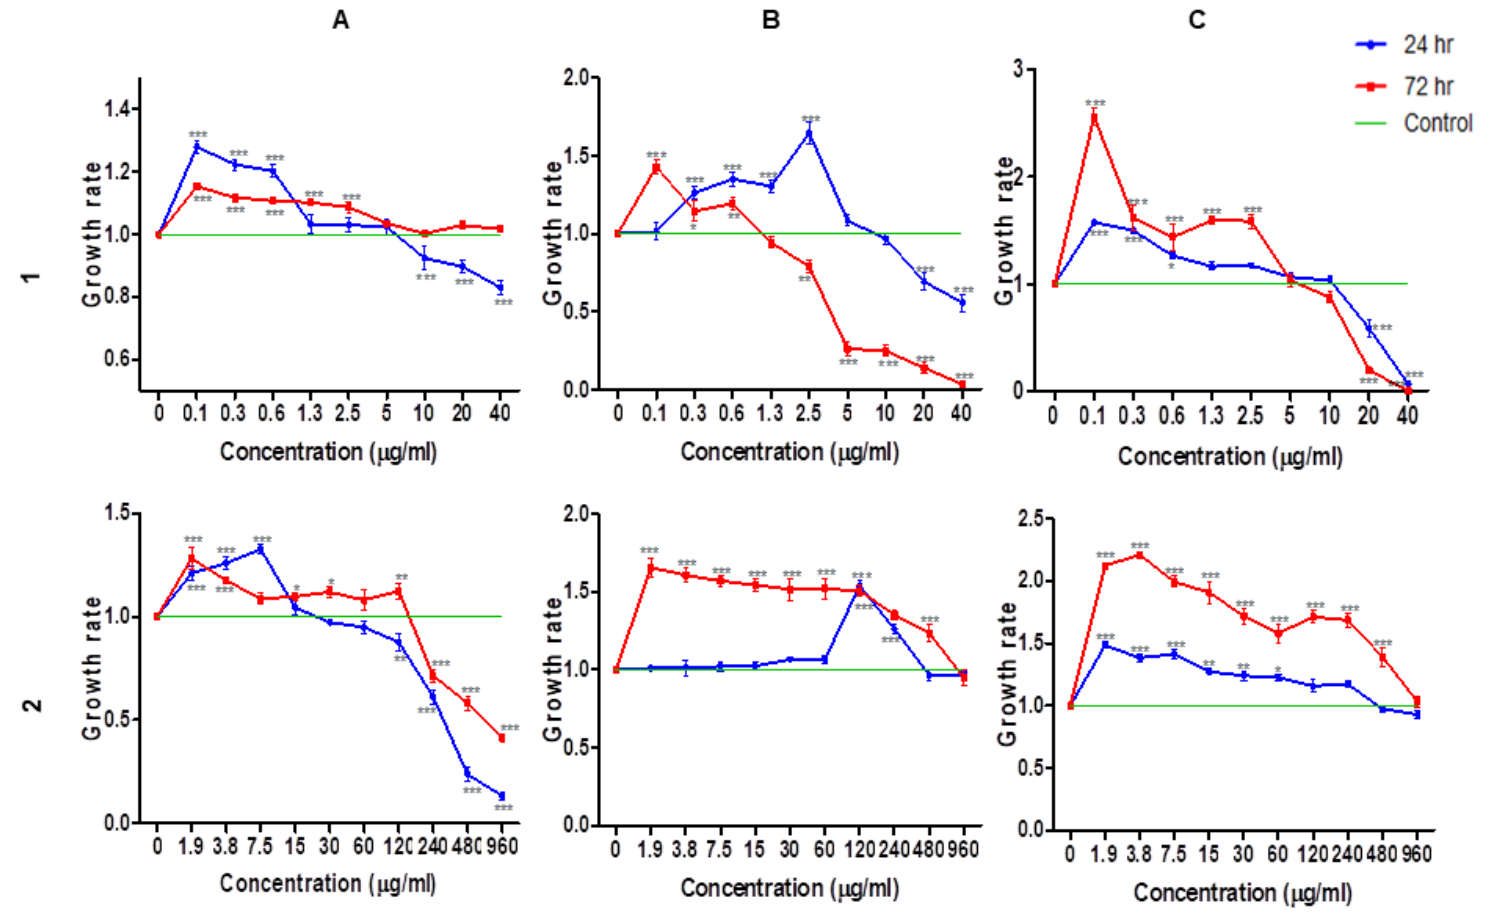
Figure 1. Effects of ( 1 ) Cotyledon -AgNPs and ( 2 ) C. orbiculata water extract on the cell viability and growth rate of ( A ) KMST-6, ( B ) HaCaT and ( C ) CHO cells after 24 and 72 h. Each value represents mean ± standard error of the mean (SEM); statistical significance of the C. orbiculata water extract and Cotyledon -AgNPs-treated cells when compared to the untreated cells is indicated with * for p < 0.05, ** p for <0.01, and *** p < 0.001.